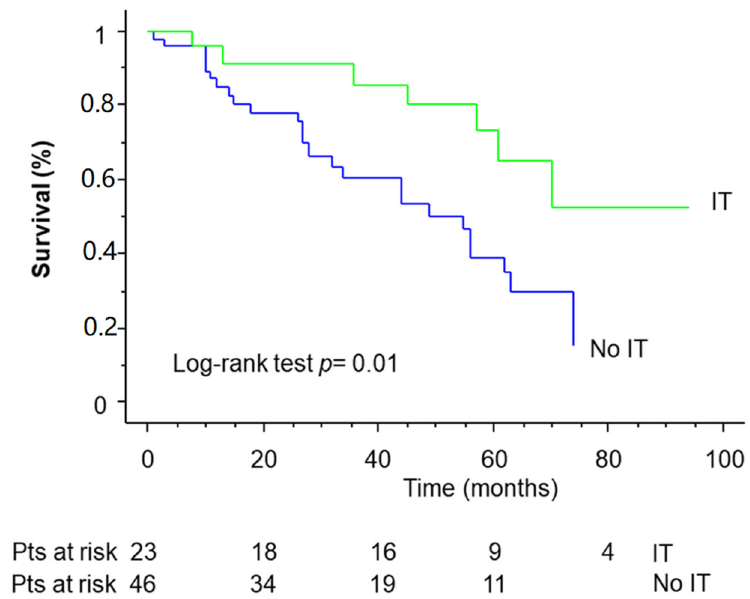
Figure 3. Kaplan–Meier survival of patients undergoing completion pneumonectomy, stratified by induction treatment.